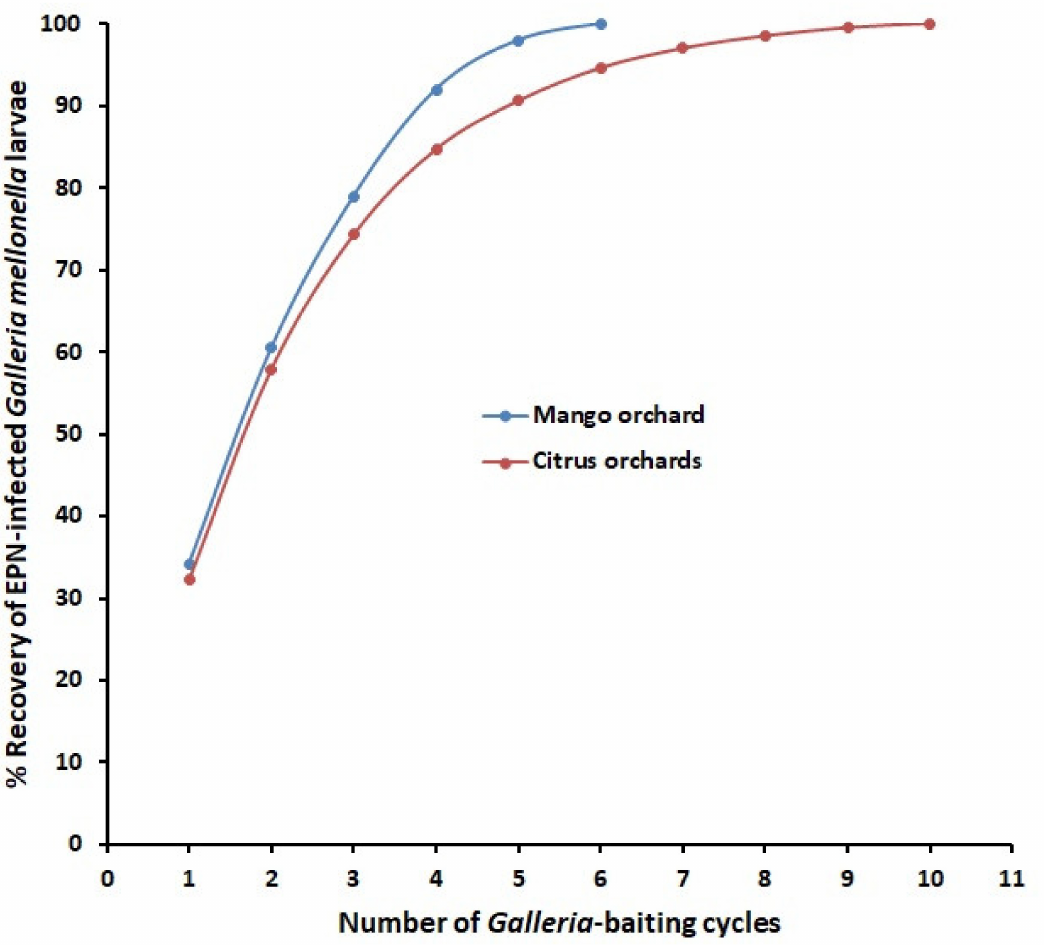
Figure 2. Calculated relationships between number of Galleria -baiting cycles and percentage recovery of entomopathogenic nematodes-infected insects for surveys of mango and citrus